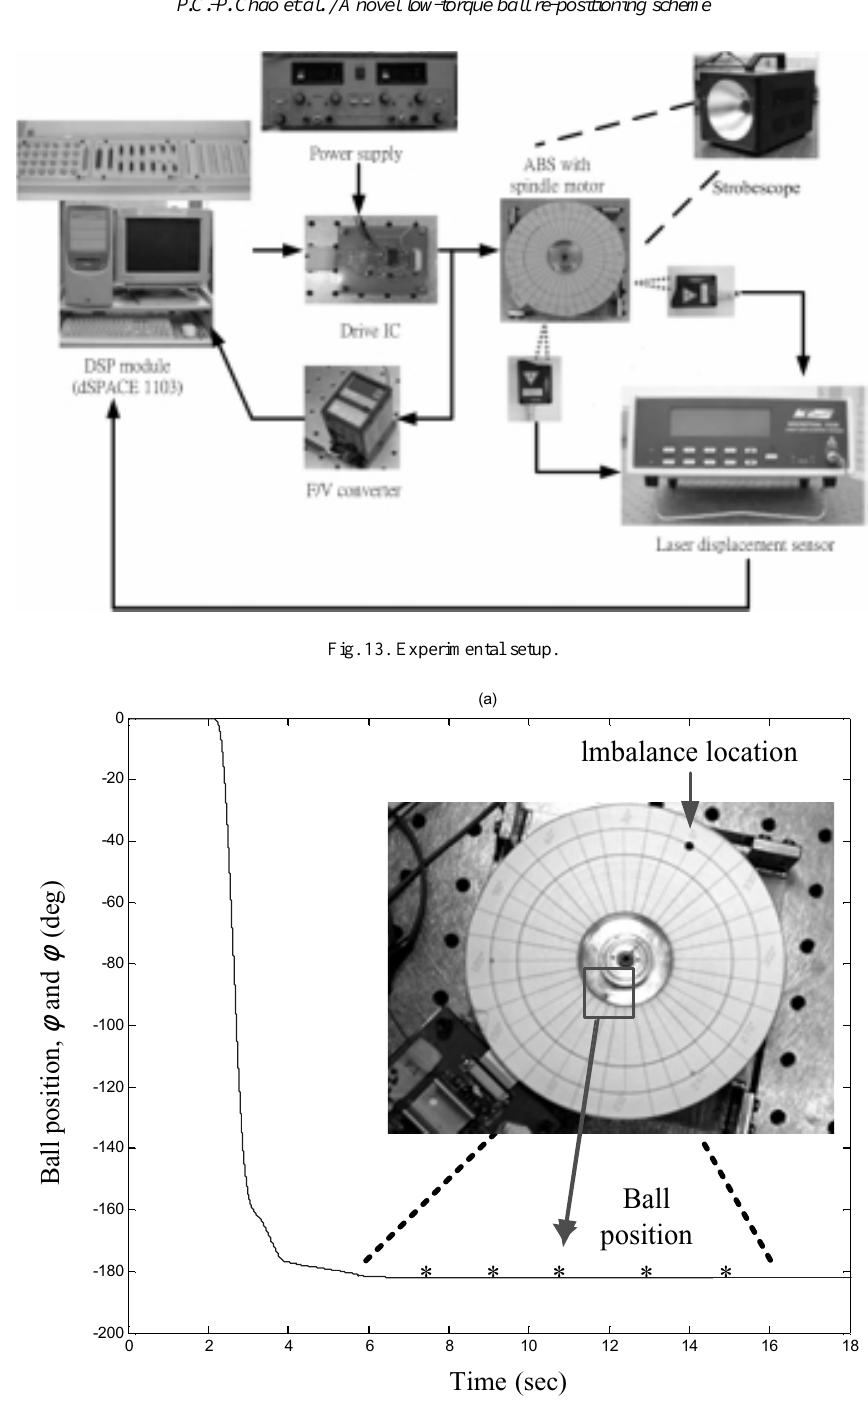
Fig. 14. (a) Observed ball position and the corresponding picture of ball position at steady state. (b) Measured and observed displacements of the stator and rotor system in X -axis. (c) The enlarged plot of Fig. 7(b) during a steady state period spanning 0.2 second. (d) Measured and observed velocities of stator and rotor system in X -axis. (e) The enlarged plot of Fig. 7(d) during a steady state period spanning 0.2 second. (f) Measured and observed displacements of stator and rotor system in Y -axis. (g) The enlarged plot of Fig. 7(f) during a steady state period spanning 0.2 second. (h) Measured and observed velocities of stator and rotor system in Y -axis. (i) The enlarged plot of Fig. 7(h) during a steady state period spanning 0.2